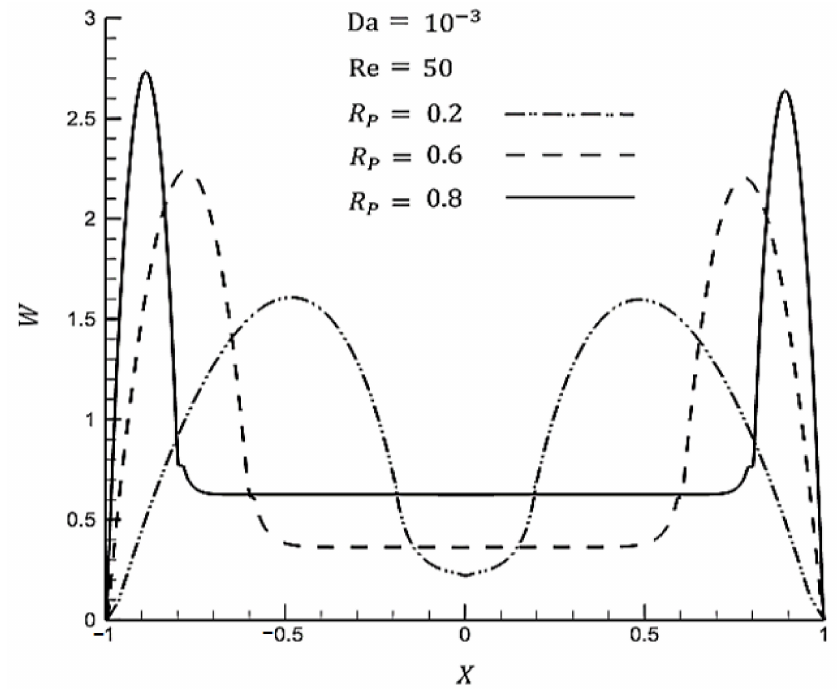
Figure 14. Effect of porous medium thickness on velocity profile in concentric state.